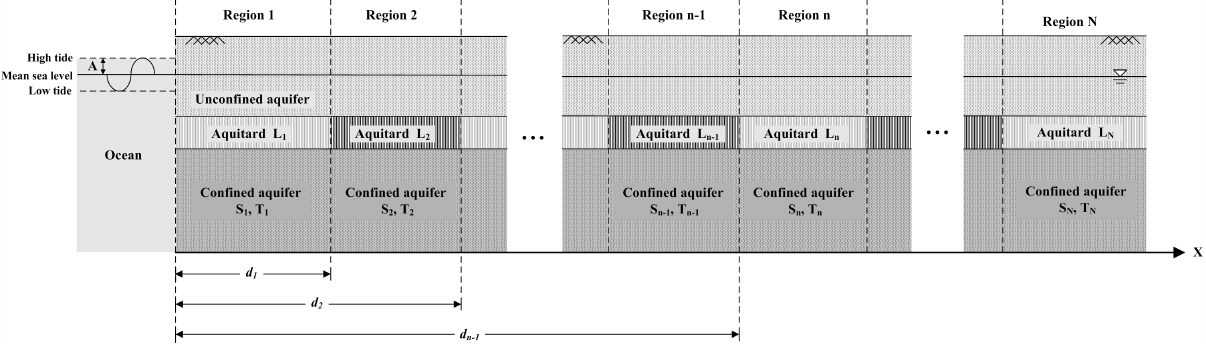
Fig. 1. Schematic diagram of a heterogeneous coastal leaky aquifer Figure 1. Schematic diagram of a heterogeneous coastal leaky aquifer system 3